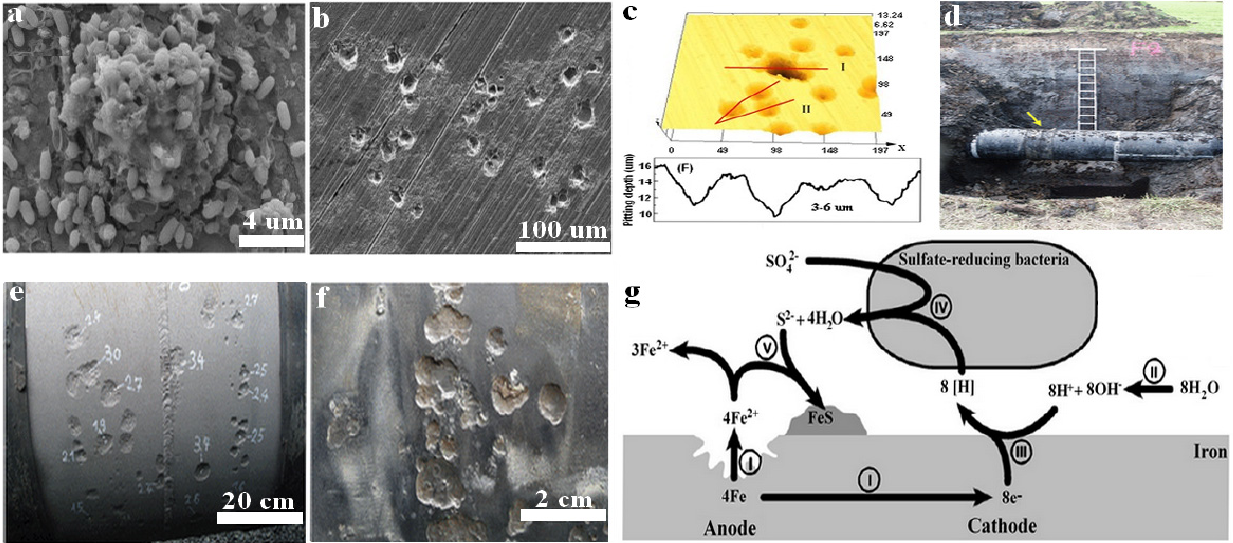
Figure 1. Biofilm formation and pitting corrosion on the surface of carbon steel measured by SEM ( a , b ). Pit depth measured by confocal laser scanning microscopy CLSM ( c ). Carbon steel pipeline in water-logged anoxic soil ( d ), where the arrow sign represents the external pitting corrosion at welding sites. Reprinted with permission from ref. [34]. Copyright 2022 Elsevier. Welding site with corrosion pits ( e ) where numbers indicate pit depth in millimetres. Higher magnification of corrosion pits from different sites at the same pipeline ( f ). Reprinted with permission from ref [22]. Copyright 2022 ASM. Schematic diagram showing the mechanism of MIC caused by SRB at iron surface ( g ). Reprinted with permission from ref. [32]. Copyright 2022 MDPI.